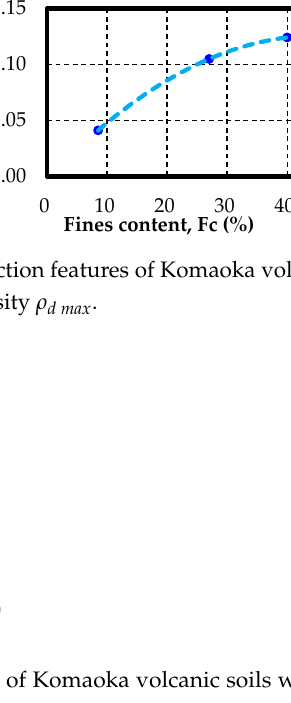
Figure 5. Maximum and minimum void ratio of Komaoka volcanic soils with different fine particle contents.